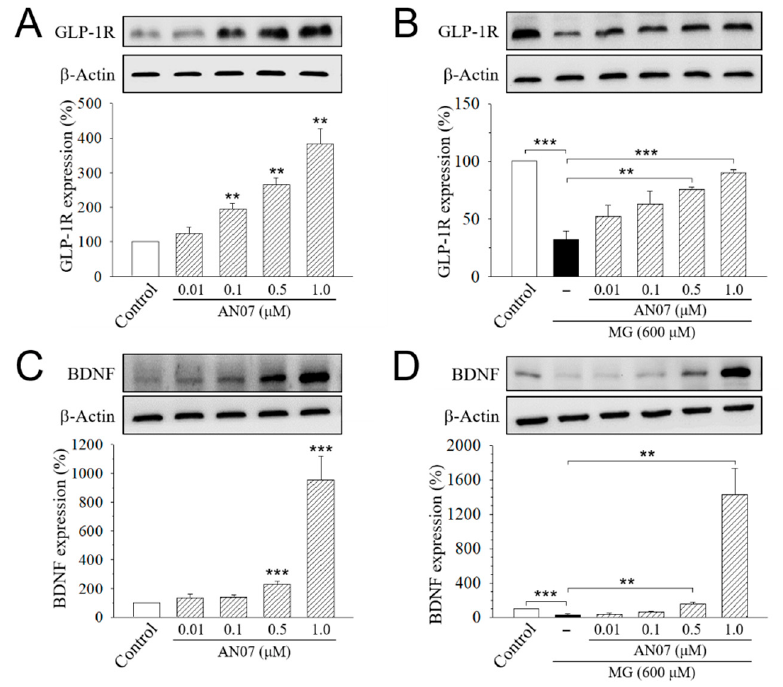
Figure 8. AN07 promotes the expressions of the glucagon-like peptide-1 receptor (GLP-1R) and brain-derived neurotrophic factor (BDNF) in normal and methylglyoxal (MG)-treated SH-SY5Y cells. AN07 itself up-regulates protein expressions of the GLP-1R ( A ) and BDNF ( C ), and AN07 pre-treatment attenuates MG-induced down-regulation of GLP-1R ( B ) and BDNF ( D ) in SH-SY5Y cells. SH-SY5Y cells were pre-treated with AN07 (0.01–1.0 µ M) for 1 h and then exposed to 600 µ M MG for another 24 h. Upper panels, representative immunoblots. Lower panels, densitometry analyses of the relative ratio of protein / β -actin protein or phosphorylated-protein ( p -protein) / total-protein ( t -protein), which are represented as percentages of the control group. Columns, mean ± S.E.M. from at least three independent experiments. ** p < 0.01, *** p < 0.001, compared with control or indicated groups.